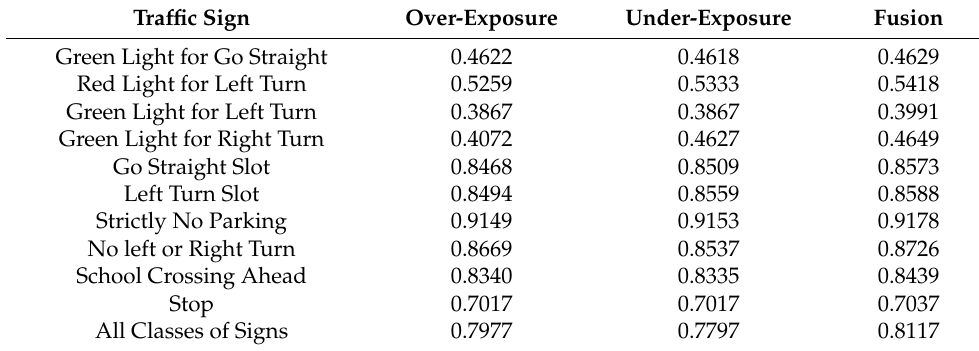
Table 3. Classification accuracy of over-exposure, under-exposure and fusion